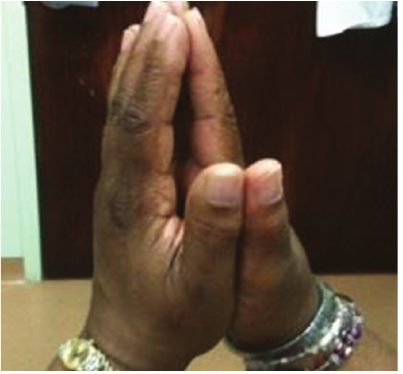
Figure 1: Positive prayer